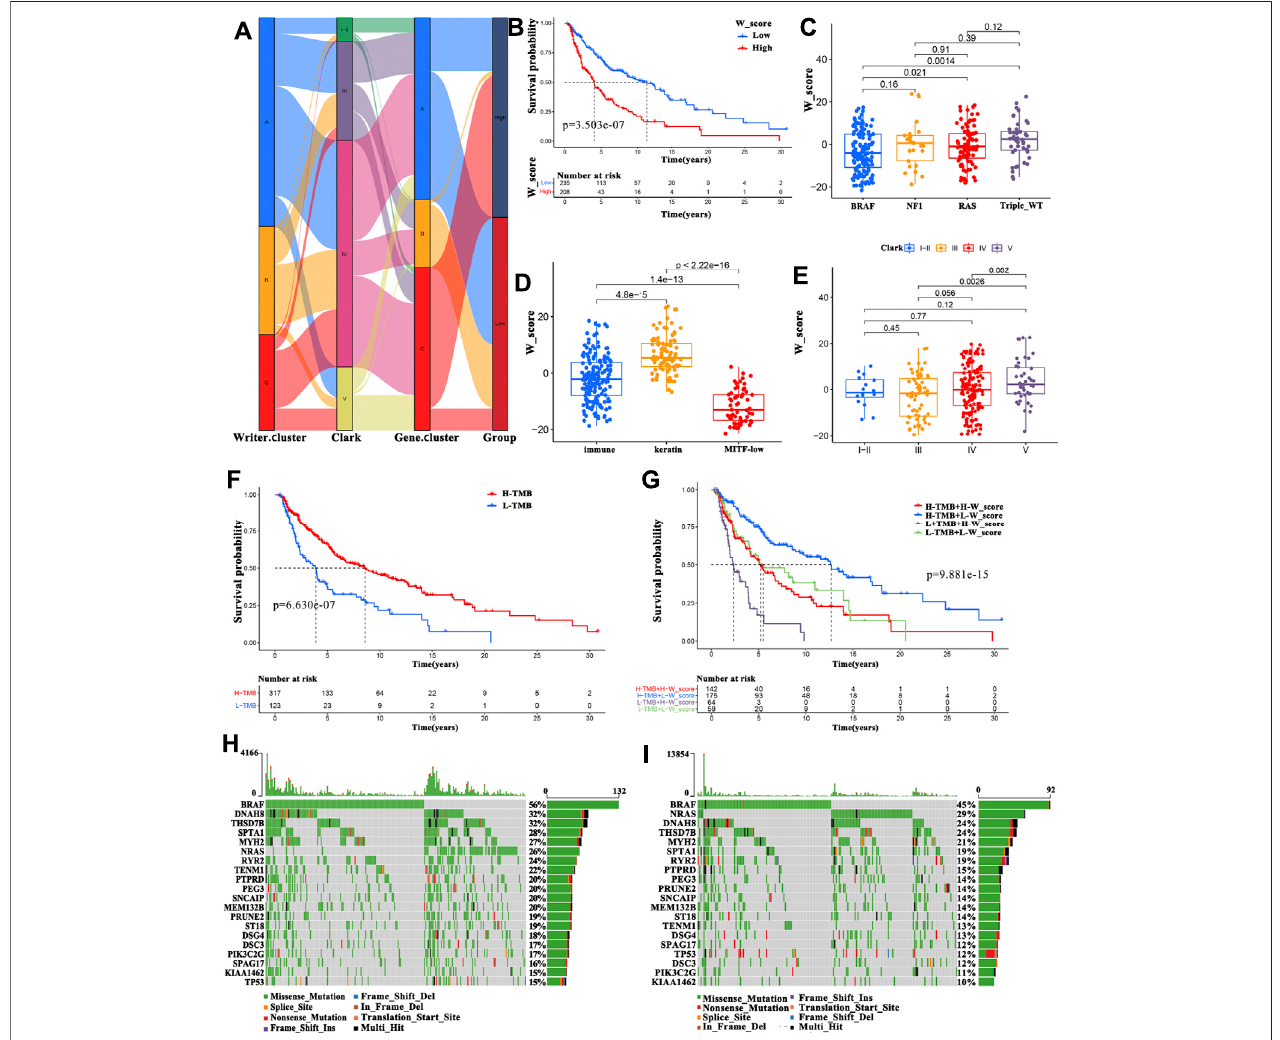
FIGURE 5 | Clinical features associated with the W_Score. (A) Alluvial diagram exhibiting the relationship among the writer cluster, Clark level, gene cluster and W_Score. (B) Survival analyses for high- and low- W_Score groups in TCGA-SKCM cohort using Kaplan-Meier curves (Log-rank test; p < 0.001). (C – E) Distribution of W_Scorein the different subtypes including gene mutations subtypes (C) , immunesubclasses (D) , and the Clark levels (E) . (F) Survivalanalysesfor high- and low- TMB groups in TCGA-SKCM cohort (Log-rank test; p < 0.001). (G) Survival analyses for high TMB and high W_Score (H-TMB + H-W_Score), high TMB and low W_Score (H-TMB + L-W_Score), low TMB and high W_Score (L-TMB + H-W_Score), and low TMB and low W_Score (L-TMB + L-W_Score) patient groups in TCGA-SKCMcohortusingKaplan-Meiercurves(Log-ranktest; p < 0.001). (H – I) Thewaterfallplotoftumorsomaticmutationconstructedinlow- (H) andhigh-W_Score (I)